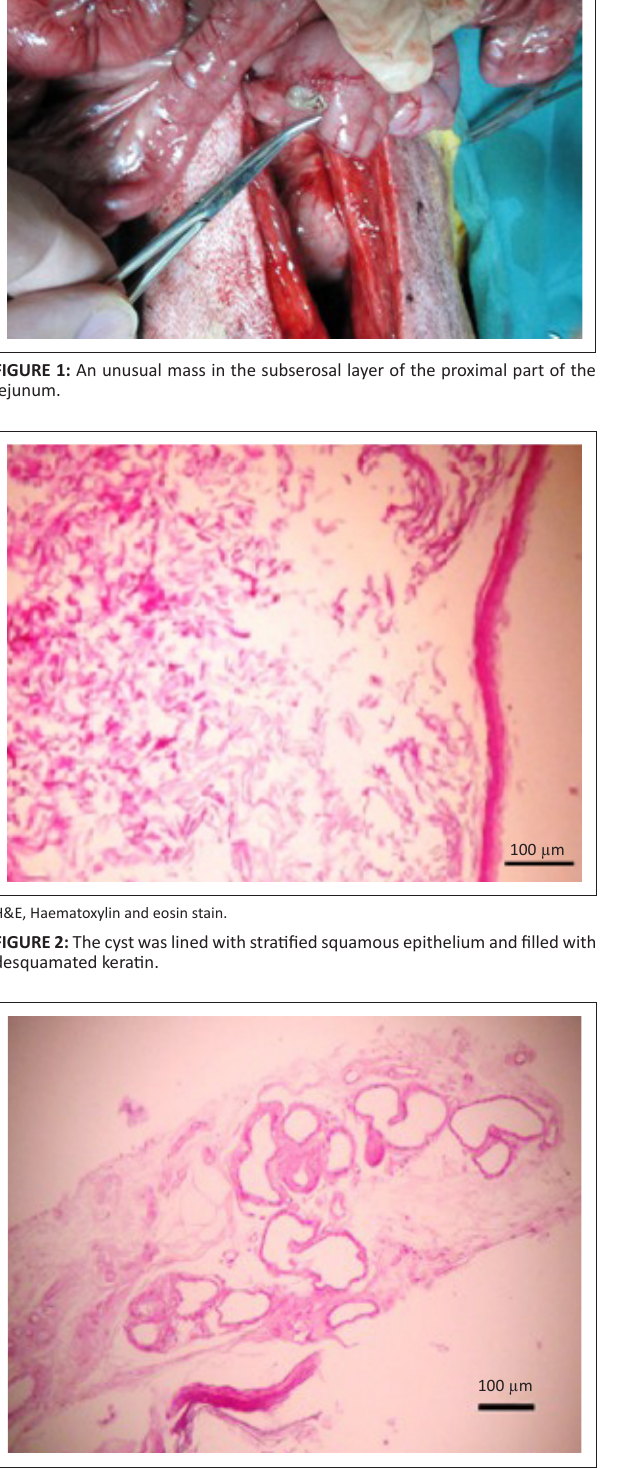
H&E, Haematoxylin and eosin. FIGURE 3: Sweat glands within the cyst wall. The majority of dermoid cysts occur on the dorsal midline because of incomplete separation of skin and neural tube during embryonic development, but they may also occur in